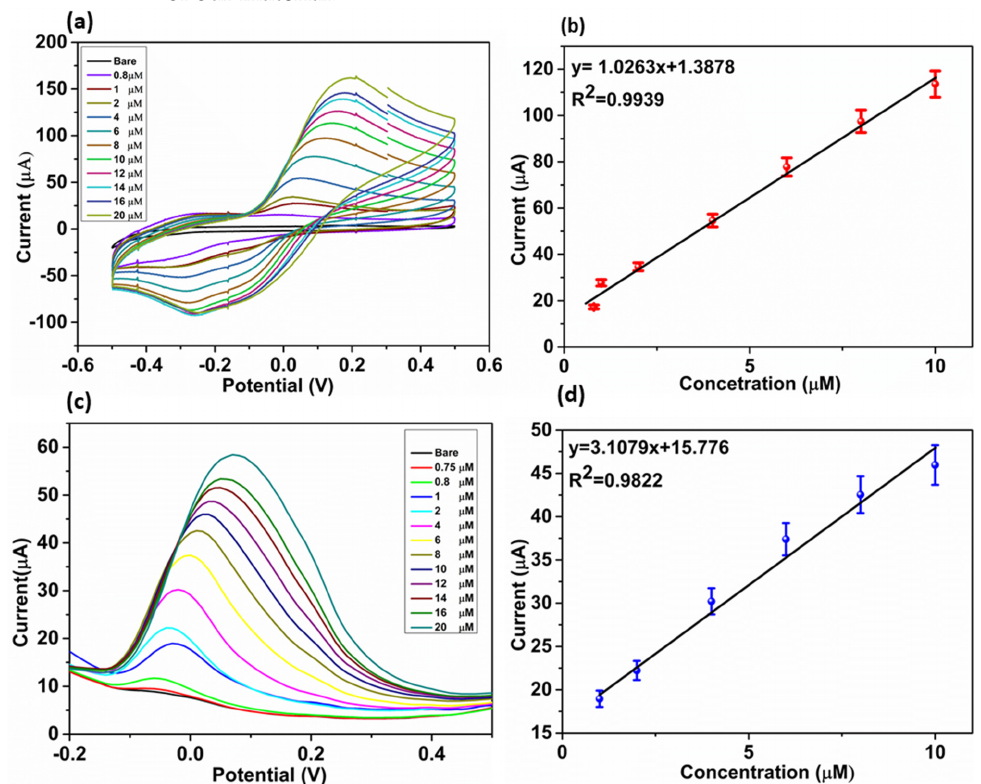
Figure 4. ( a ) CV curves of I 2 ‐ CMP ‐ CNT ‐ 4 with the following addition of DA (0.8 to 20 μ M); ( b ) plot of anodic peak current vs. concentration (0.8–10 μ molar DA); ( c ) DPV curves of I 2 ‐ CNT ‐ CMP ‐ 4 with following the addition of DA (0.75–20 μ M); ( d ) plot of oxidation peak current vs. concentration (1– 10 μ M DA). Table 1. A comparison study of I 2 -CMP-CNT-4-modified GCE with other modified